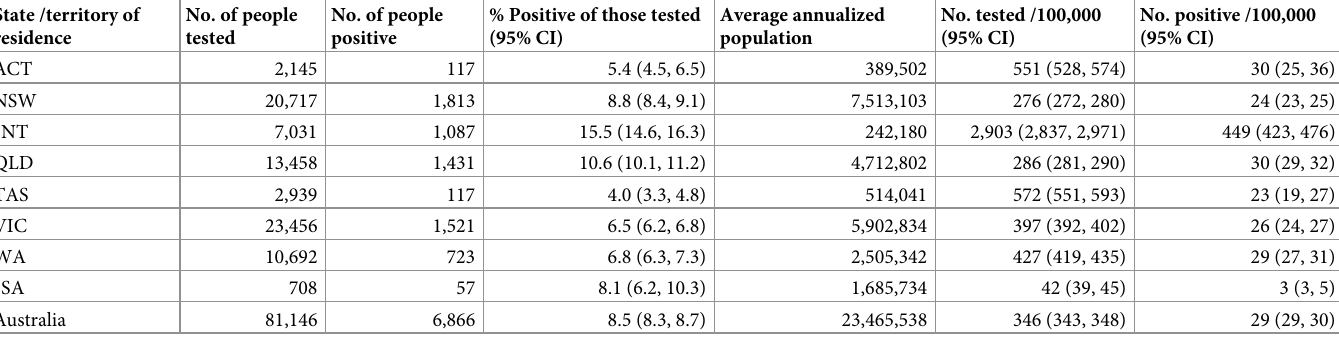
Table 2. Strongyloides serology: summary of seropositivity for each state and territory, 2012–2016, excluding data from the laboratory that provided positive data only �